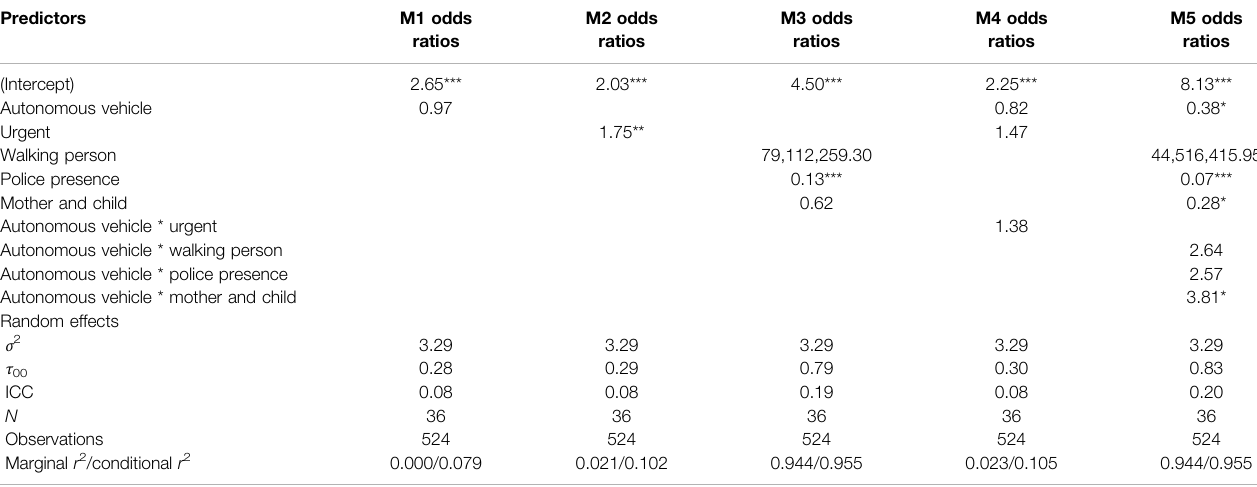
TABLE 2 | Risk-controlled results for the effect of vehicle type, task urgency, and social control on crossing decisions. Predictors